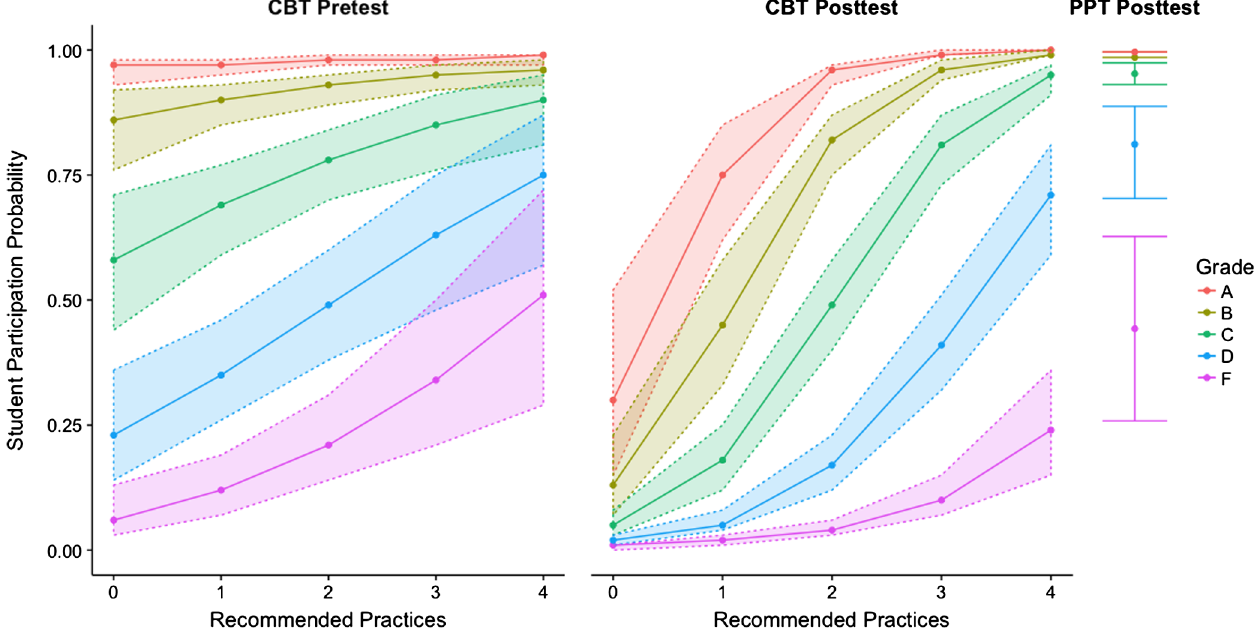
FIG. 2. Participation rates for computer-based tests and paper-and-pencil tests from Nissen et al. [2]. Participation on the PPT pretest is not shown because it closely clustered around 100% for all grades. Recommended practices measured the total number of up to four actions instructors could take to motivate students to participate in the CBTs: participation credit on the pretest, participation credit on the post-test, in class reminders, and email